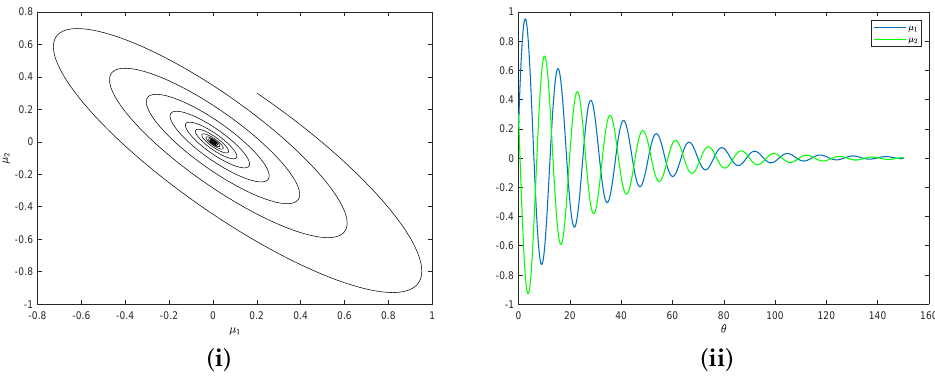
Figure 2. ( i ) Phase diagram of the circuit system for µ 0 = ( 0.2,0.3 ) , a 1 = 0.5, a 2 = 0.3, b = 0.9, c = 2, and f = 0; ( ii ) evolution of the state µ 1 , µ 2 .